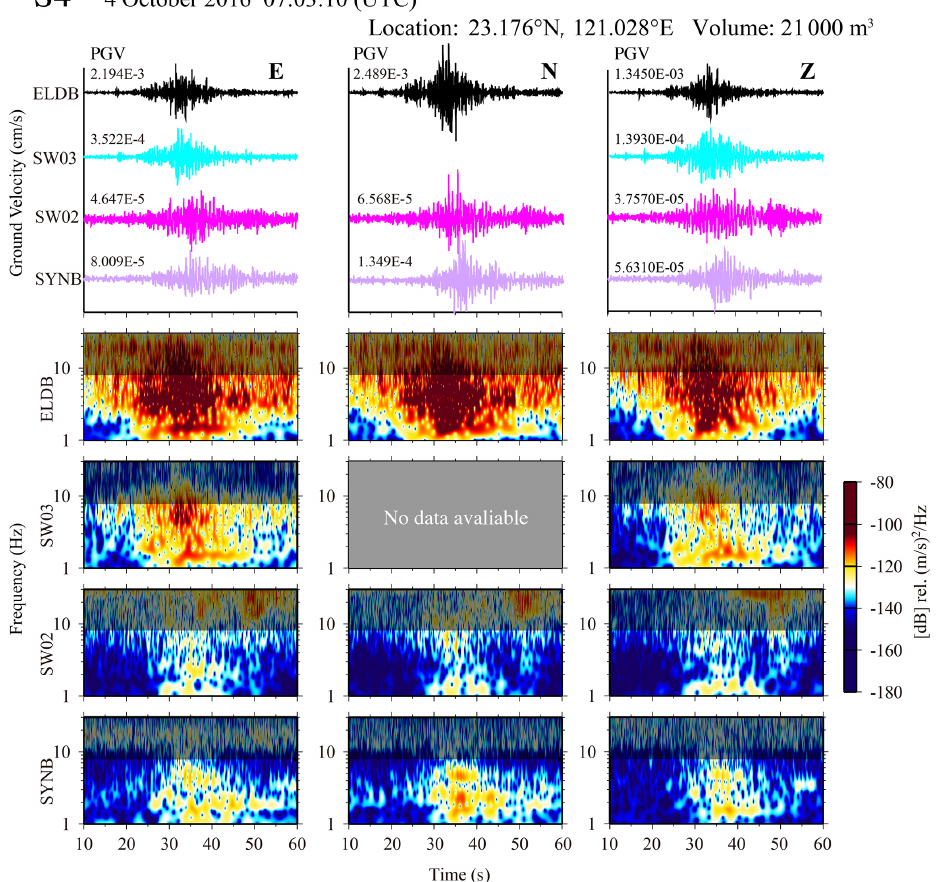
Figure 3. Recorded waveform and spectrogram of Event S 4. The value next to the waveform is the peak ground velocity (PGV) for each signal. The bright area of the spectrogram is the range of the band-pass filter (1–8Hz, f L to f H ), which should cover the signals of all stations recorded during the